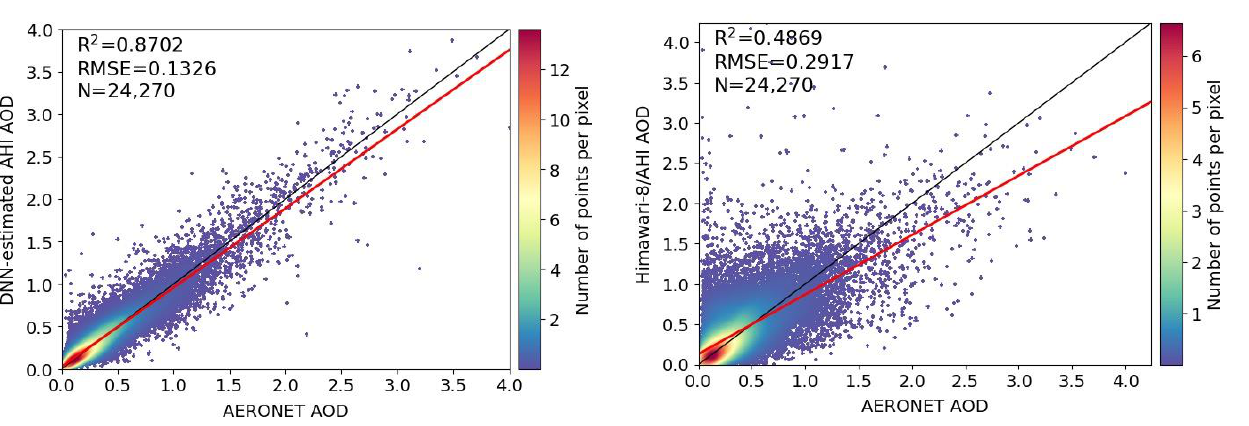
Figure 6. Comparison between the AHI AOD and AERONET AOD (( left panel ): DNN-estimated AHI AOD; ( right panel ): AHI AOD product).